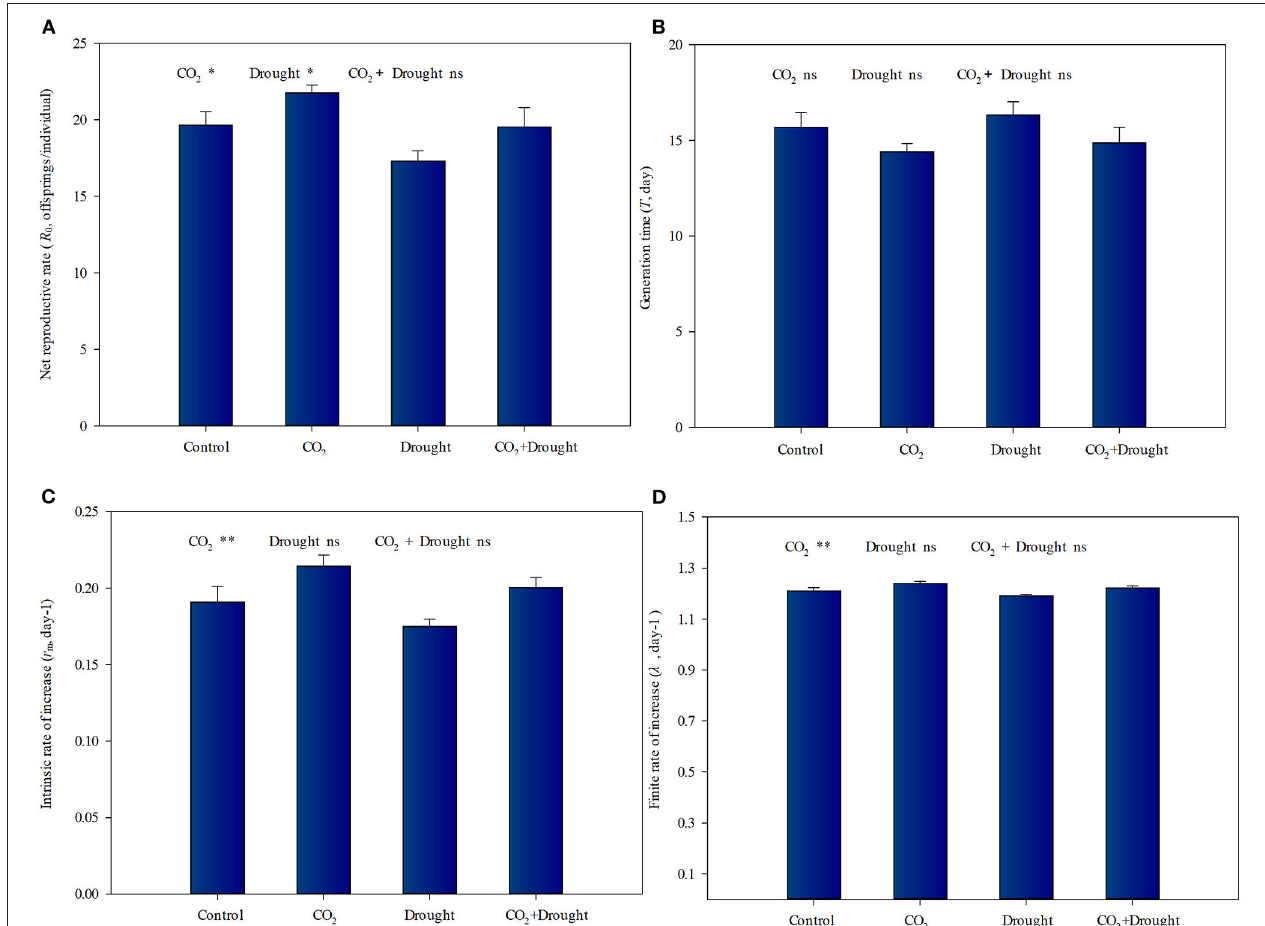
FIGURE 6 | Life table parameters of aphid reared on Triticum aestivum grown under elevated CO 2 and drought conditions. (A) net reproduction rate ( R 0 ); (B) generation time ( T ); (C) intrinsic rate of increase ( r m ); (D) finite rate of increase ( λ ). Each value shown represents the mean ( ± SE) of three replicates. P- values are provided for two-way ANOVA on the effects of elevated CO 2 and drought treatments on life table parameters. Significant differences: * P < 0.05; ** P < 0.01; ns, P > 0.05.